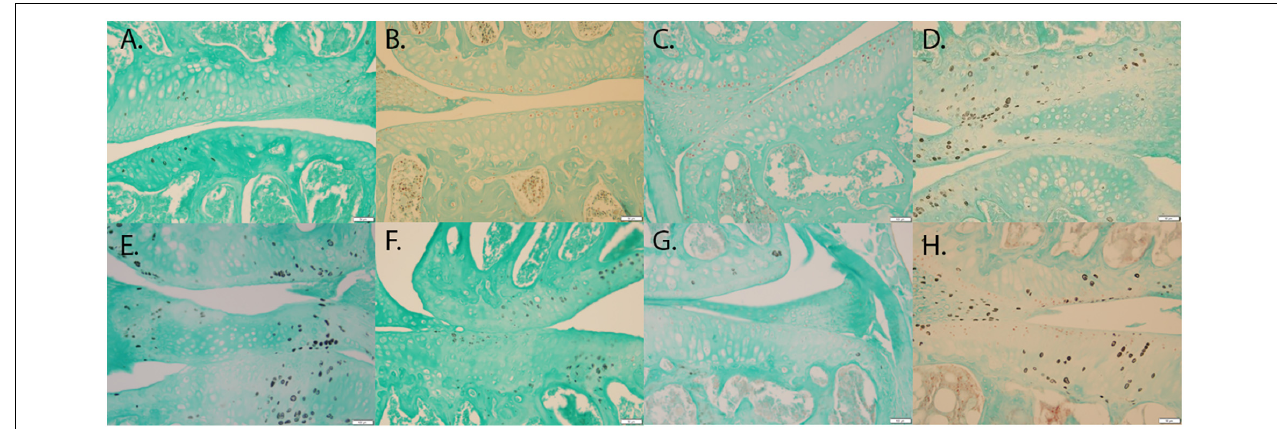
FIGURE 4 | Representative images showing the results of the immunohistochemical and histological staining performed to analyze the presence of OA biomarkers. Although, Bbs1 M390R/M390R mutant and WT mouse knees did not exhibit a statistical difference in cartilage erosion scoring, we analyzed separately cell staining within the three major age (week) categories examined – 10–14 (WT n = 8; Bbs1 M390R/M390R mutant n = 18), 15–18 (WT n = 24; Bbs1 M390R/M390R mutant n = 39), 21+ (WT n = 12; Bbs1 M390R/M390R mutant n = 4). All tissue samples represented in this figure were age matched at 14 weeks. The patterns of cell staining for biomarkers examined did not differ significantly with age. (A) WT MMP-13; (B) WT HTRA-1; (C) WT TGF- β 1; (D) WT DDR-2; (E) Bbs1 M390R/M390R mutant MMP13; (F) Bbs1 M390R/M390R mutant HTRA-1; (G) Bbs1 M390R/M390R mutant TGF- β 1; (H) Bbs1 M390R/M390R mutant DDR-2.